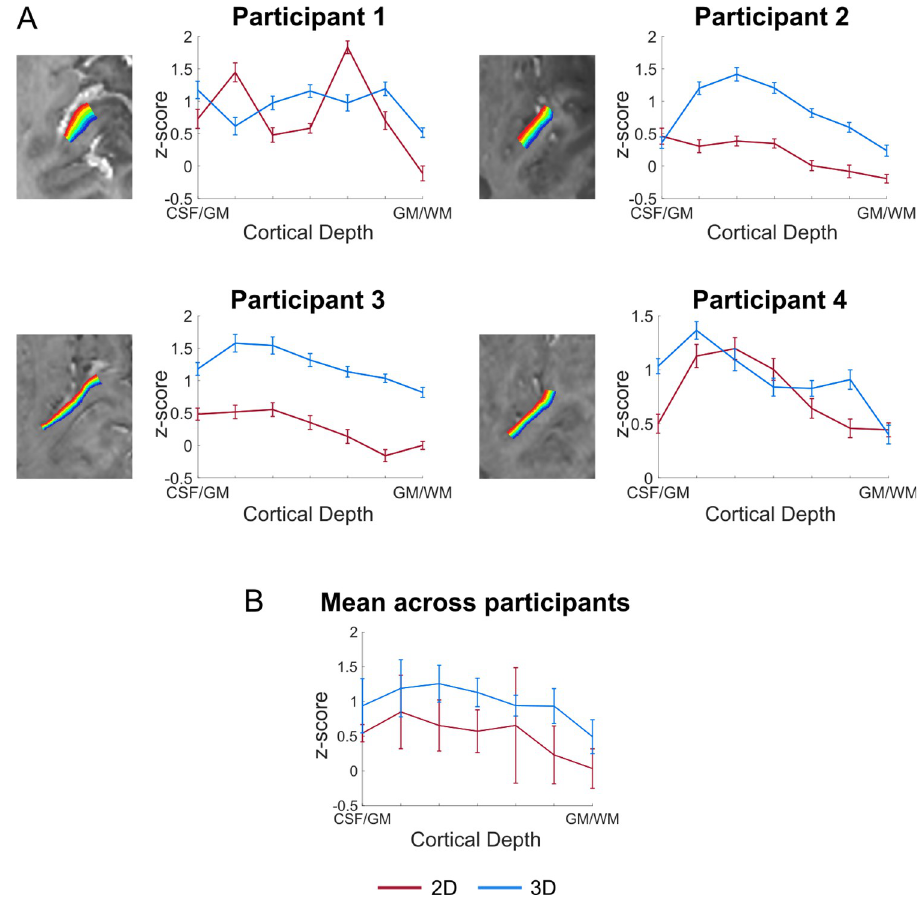
Fig 4. Z-scored cortical depth-dependent activation changes for the 2D- and 3D-EPI VASO data. The ROI was drawn on an axial slice as shown in Fig 3A and was based on functional activation. (A) The fMRI layer-dependent changes across depths for each participant. (B) Average z-scored layer-dependent activation changes across